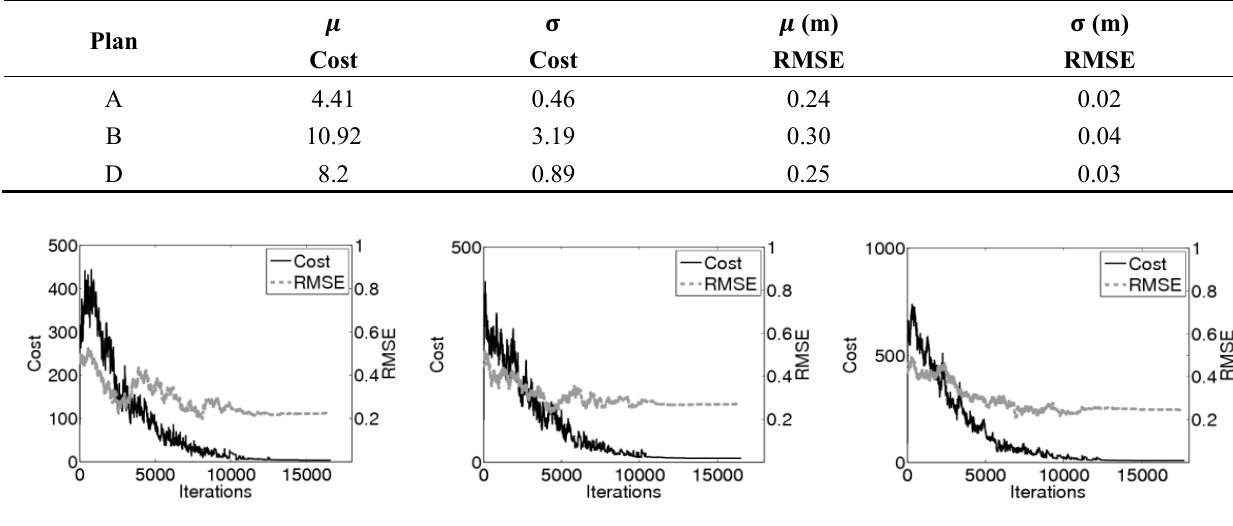
Table 3. Stability results.